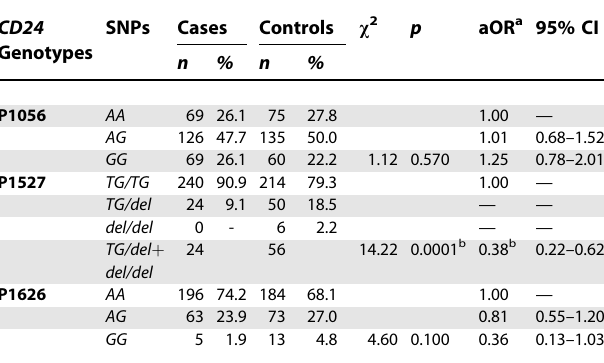
Table 4. CD24 Genotype Frequencies for All SLE Participants and